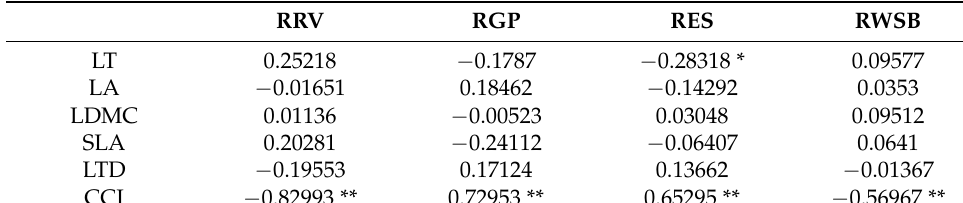
Table 2. Pearson correlation analysis between plant traits and spectral parameters. * indicates that the correlation reaches a significant level at the level of p < 0.05. and ** indicates a significant correlation reaches a significant level at the level of p < 0.01.